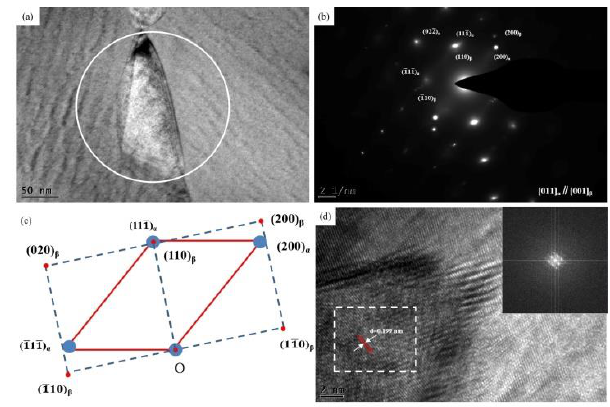
Figure 11. Microstructure of the β phase in Cu-2.7Be samples annealed at 650 °C for 2 min: ( a ) TEM image; ( b ) the SAED of white circle area in ( a ); ( c ) schematic representation of ( b ); ( d ) high resolution transmission electron microscopy (HRTEM) image of ( a ), the inset show the Fast Fourier Transform (FFT) of rectangular region.